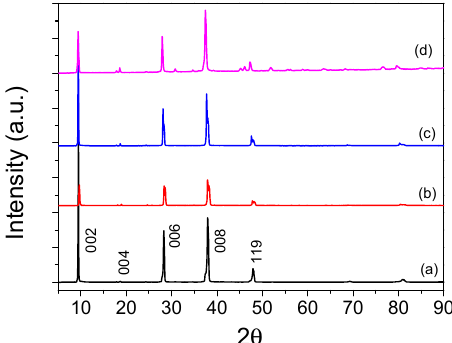
Figure 5. XRD patterns of MA 2 CuCl 2 Br 2 perovskite powders upon irradiation with a solar simulator (1000 W / m 2 ): ( a ) fresh sample, ( b ) after 24 h, ( c ) 48 h and ( d ) three weeks reaction. The relatively minor changes in the relative peak intensity and FWH peak are due to unavailable variation in the packing of the solid and surface levelling when filing the cell holder.